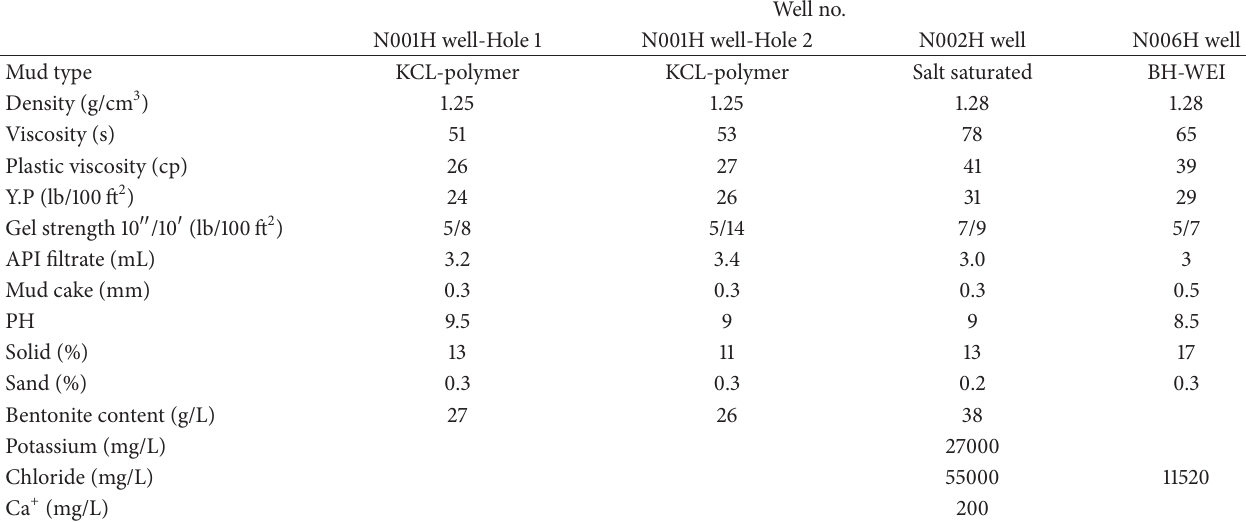
Table 1: The drilling fluid properties of three horizontal wells of Nahr Umr Formation.